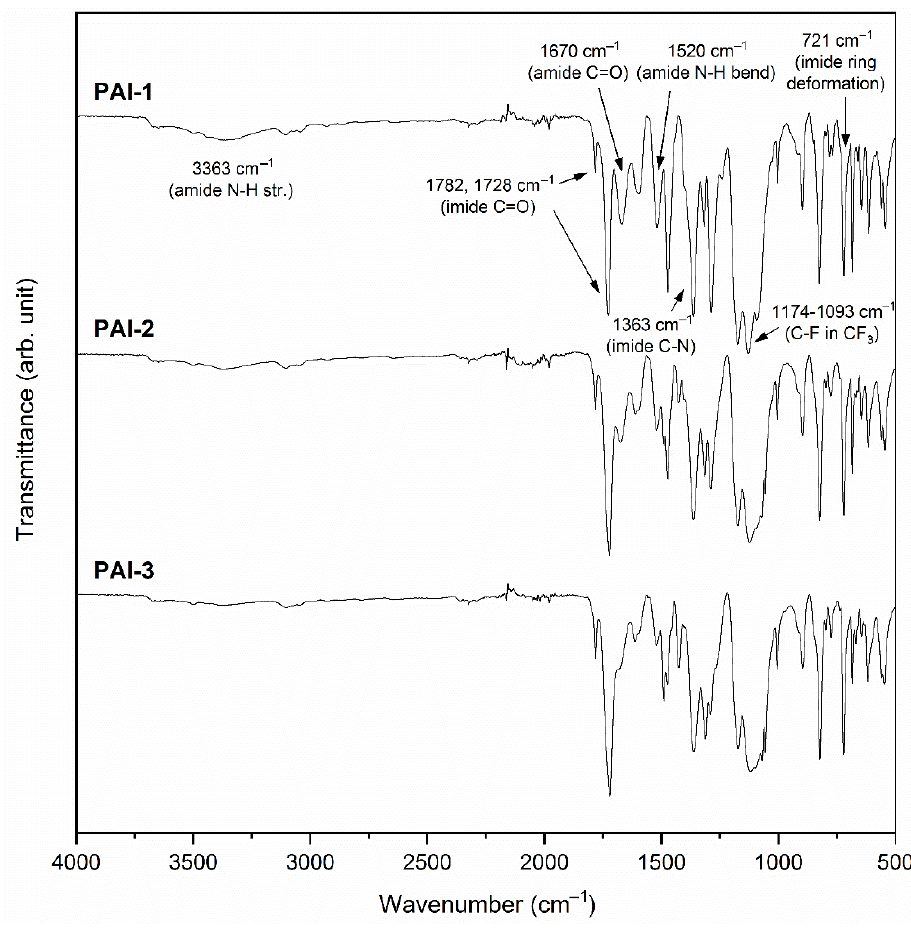
Figure 3. FT-IR spectra of the PAIs.